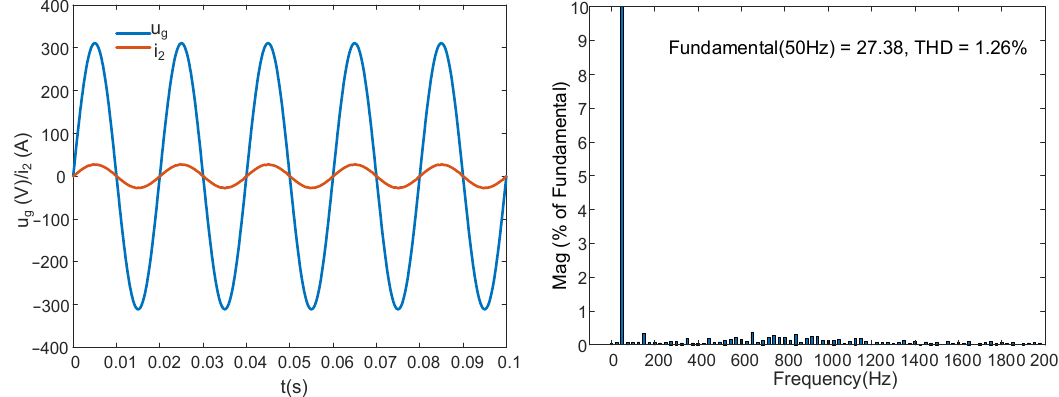
Figure 15. Simulation results of the “FOGCI + FOPI” system with α + β = 2. The simulation results showed that each system had small stable-state error and that the grid current THD of the FOGCI was lower than that of the IOGCI under both IOPI and FOPI control. 5.2.2. FOGCI without Capacitor Current Proportional Feedback For the FOGCI, the capacitor current proportional feedback was omitted in this case. The inductor order